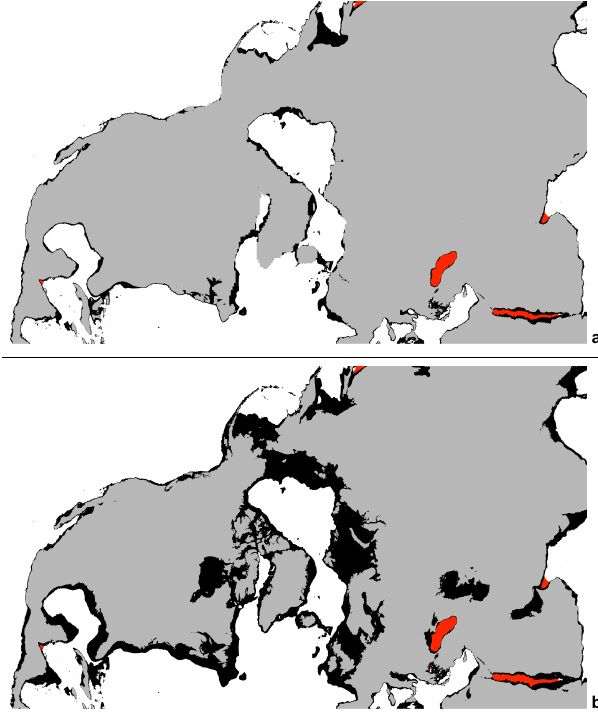
Figure 4: Ocean mask and topographic regions for the LGM (a) and the present day (b). 2 Fig. 4. Ocean mask and topographic regions for the LGM (a) and Regions with a depth between current sea level and the depth threshold (R3, black) close the 3 the present day (b) . Regions with a depth between current sea level gap between topographic coast (R2, grey) and extended ocean mask (R5, white). Map border 4 and the depth threshold (R3, black) close the gap between topo- graphic coast (R2, grey) and extended ocean mask (R5, white). Map points (R1, unmarked) and internal ocean regions, which are below the depth threshold but 5 border points (R1, unmarked) and internal ocean regions, which are not part of the extended ocean mask (R4, red) are mapped to nearby ocean grid points. 6 below the depth threshold but not part of the extended ocean mask (R4, red) are mapped to nearby ocean grid